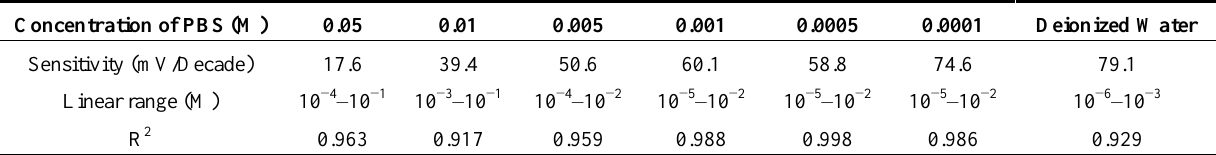
Table 2. Effect of PBS (pH 7) concentration on the performance of urea biosensor sensitivity.